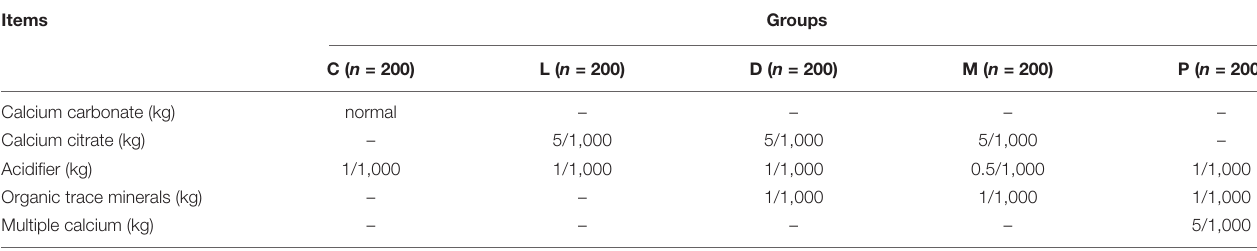
TABLE 2 | Experimental diets for one thousand weaned